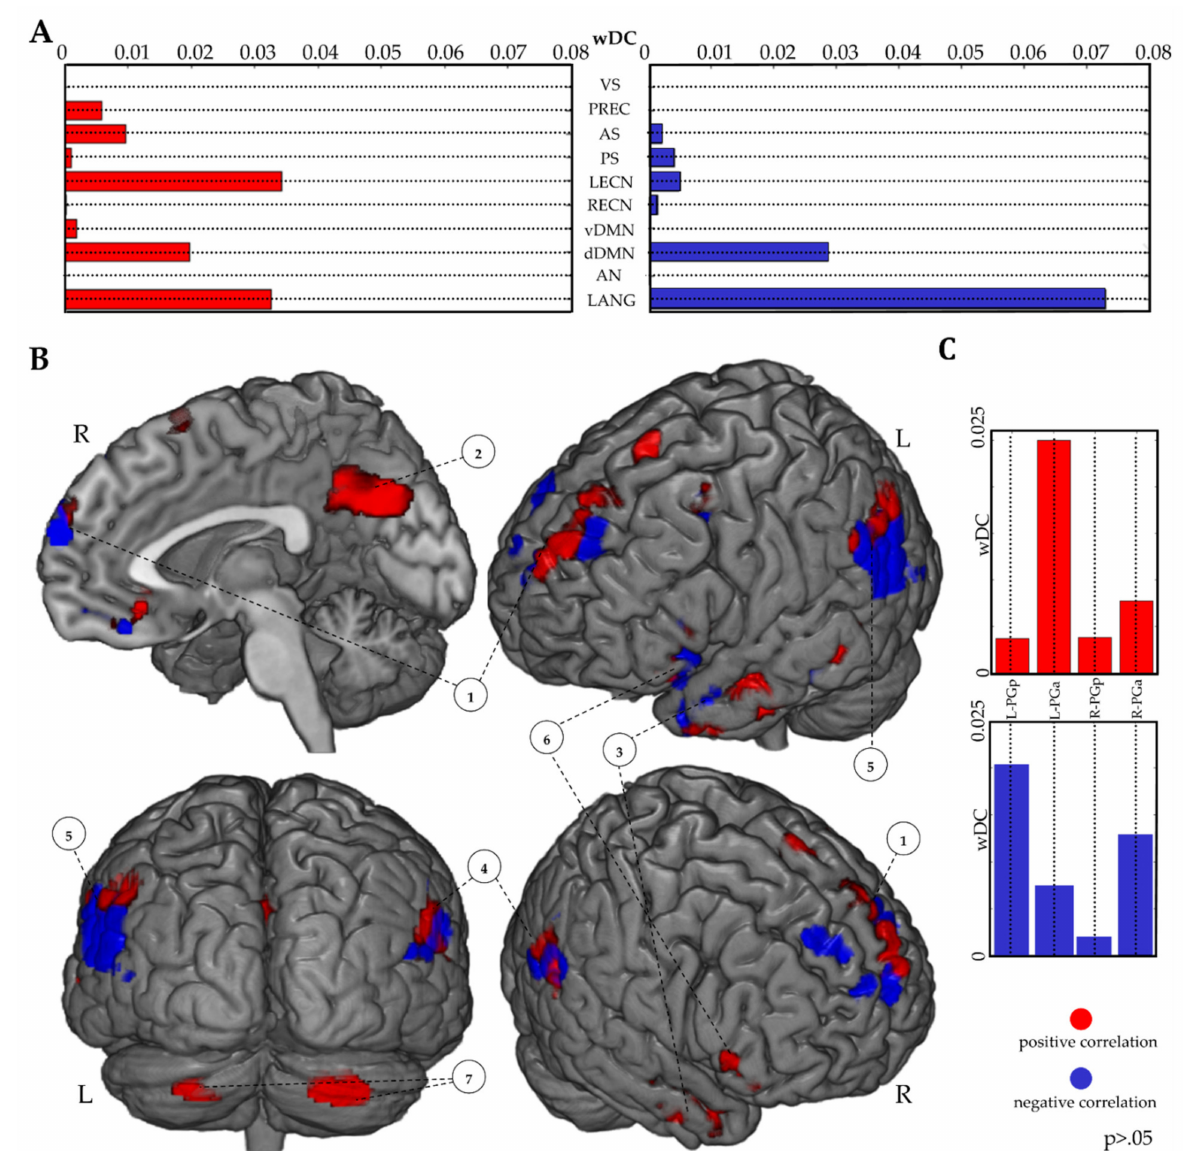
Figure 4. Performance-based analysis results. wDC analysis results using suprathreshold correlational maps ( p > 0.05; FR > BC contrast; IR as a covariate of interest) and functional RSNs ( A ). Suprathreshold correlational maps ( p > 0.05; FR > BC contrast; IR as a covariate of interest) are reported ( B ). wDC analysis results between suprathreshold correlational maps and AG of the IPL parcellation atlas ( C ). A positive correlation is shown in red; a negative correlation is shown in blue. 1: Bilateral Superior/Medial Frontal Gyrus; 2: Precuneus and PPC; 3: Left Middle Temporal Gyrus; 4: Left IPL; 5: Right IPL; 6: Left Inferior Frontal Gyrus; 7: Bilateral